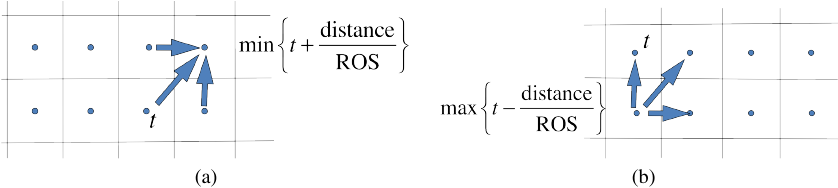
Fig. 2. (a) Propagation of ignition time t to a node from neighboring nodes already on fire. (b) Backtracking (propagation back in time) of ignition time to a node from neighboring nodes where the fire arrived later.